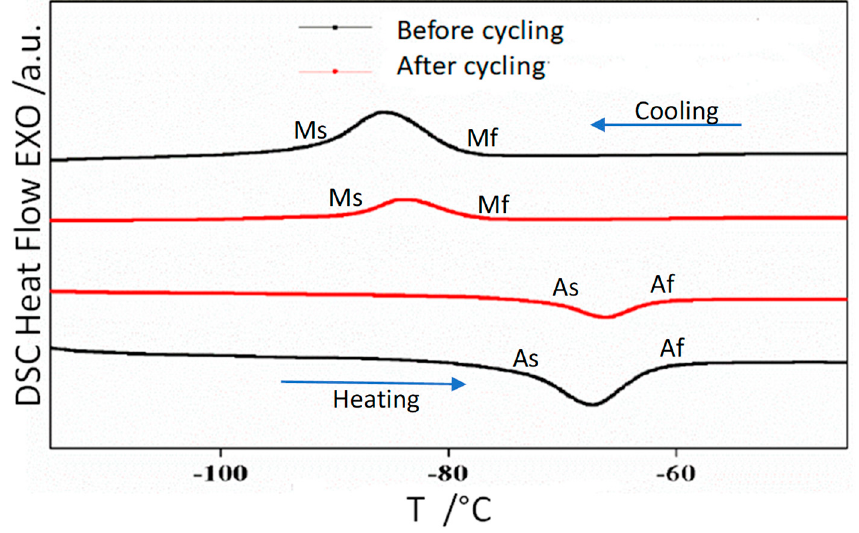
Figure 2. DSC reversible scans of alloy Ni 50 Mn 36 Sn 14 before and after 100 thermal cycles.